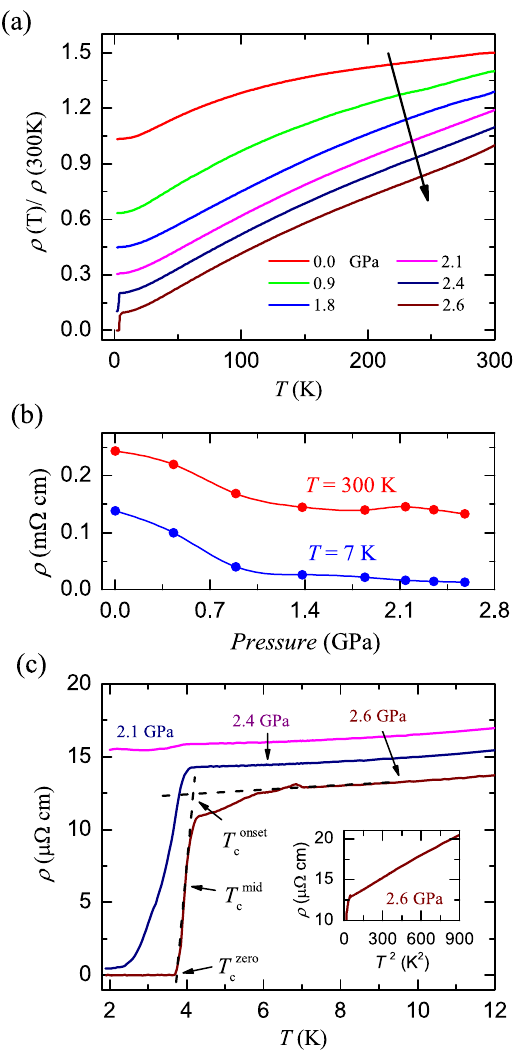
Figure 3. ( a ) Temperature dependence of the normalized in-plane resistivity, ρ ( T )/ ρ (300 K ), for a BaMnBi 2 crystal under various pressures up to 2.6 GPa. Note that each subsequent data set is shifted upward by 0.1 for clarity. ( b ) Pressure dependence of ρ measured at 300 K and 7 K. ( c ) The low temperature ρ ( T ) curves measured at various pressures. The criteria used to determine the onset, middle and zero temperatures for the superconducting transitions. Inset: ρ as a function of T 2 below 30 K under 2.6